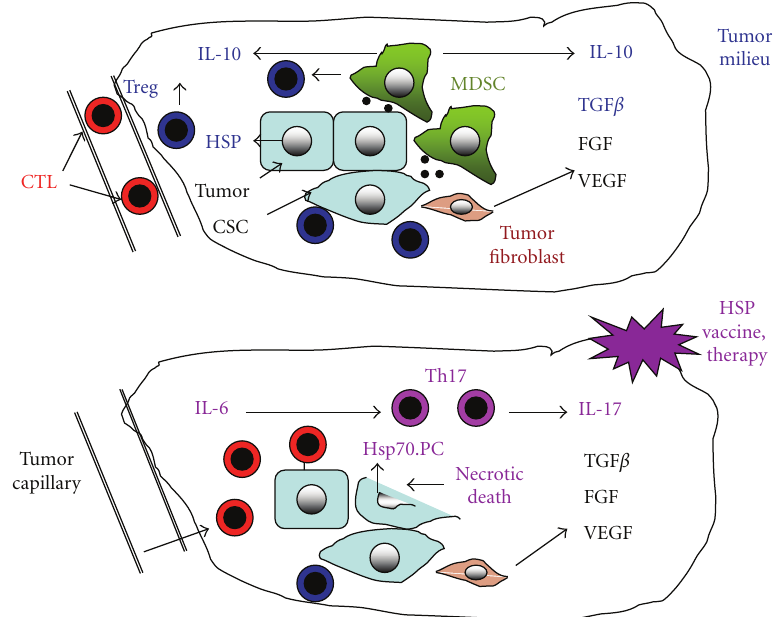
Figure 1: The cell biology of the tumor milieu: the role of heat shock proteins. The upper part of the figure depicts tumor cells (pale blue), including cancer cells with a cuboid epithelial shape and more spindle-shaped cancer stem cells (CSCs), suggesting the EMT (epithelial- mesenchymal transition) characteristics ascribed to CSC. The tumor is represented as a heterogeneous cell colony containing myeloid suppressor cells (MDSCs; green), Treg (dark blue), and tumor-associated fibroblast (TAF; orange). Dominant cytokines in the tumor microenvironment include IL-10 and TGF β . The growth factors FGF and VEGF are secreted by TAF. To the left of the figure is depicted a tumor capillary containing CD4+ T cells (red) that have stalled at the capillary wall. Tumor cells are depicted as secreting Hsp70-containing exosomes (black circles) that recruit MDSCs as well as free Hsp70 that may also trigger immunosuppressive responses. The lower section suggests the potential e ff ects of therapy using molecular chaperone vaccines, in which IL-6 is now at high levels and the cytokine profile is proinflammatory, cognate CTL has crossed the capillary wall, penetrated the tumor interstitial spaces, and recognized MHC class I associated with tumor antigens. Such tumor cells can then be killed in an antigen-specific manner. In addition, Hsp70-peptide complexes (Hsp70.PC) are secreted from necrotic tumor cells and can trigger anticancer CTL after entering APC and cross-presentation to CD4+ T cells in a ff erent lymph